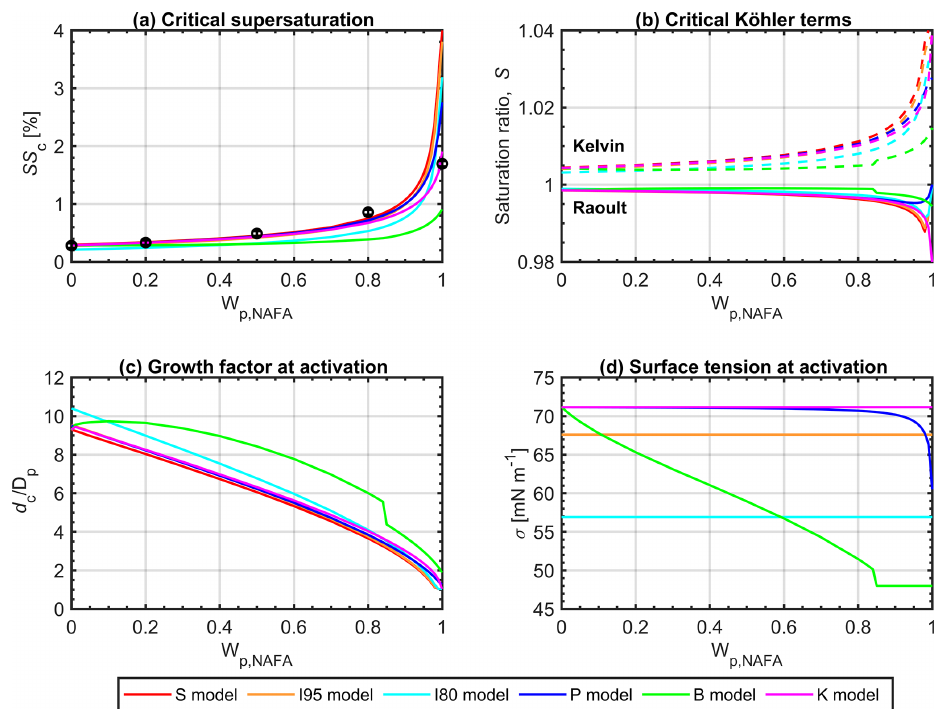
Figure 2. Properties of activating droplets calculated with models (P), (S), (I), (B), and (K) at the critical point of droplet activation d c for 50nm dry particles as functions of dry-particle NAFA mass fraction W p , NAFA : (a) critical supersaturations SS c , (b) Kelvin and Raoult terms, (c) droplet diameter growth factor, and (d) droplet surface tension, all at the critical point of the Köhler curve corresponding to each SS c . In panel (a) , experimental values from Kristensen et al. (2014) for particles with similar dry sizes are shown for